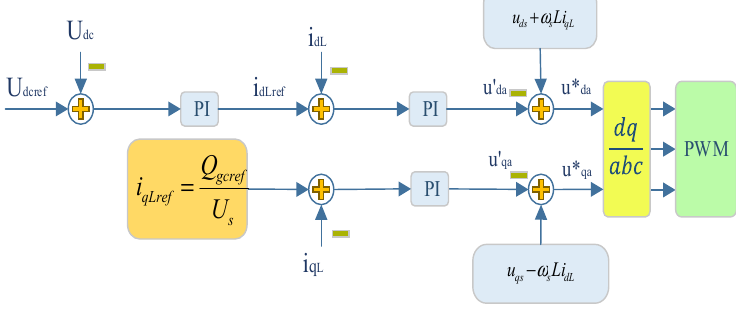
Figure 4. Control structure for the GSC.